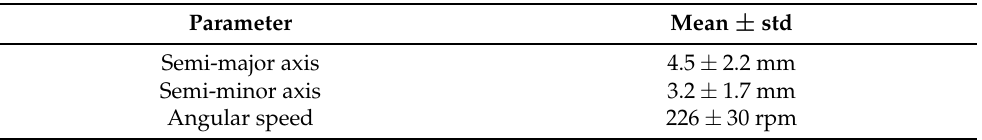
Table 3. Statistical results obtained from a panel of more than 80 people recorded while swirling an INAO glass filled with 100 mL of distilled water. For each parameter, the arithmetical mean is presented together with its standard deviation